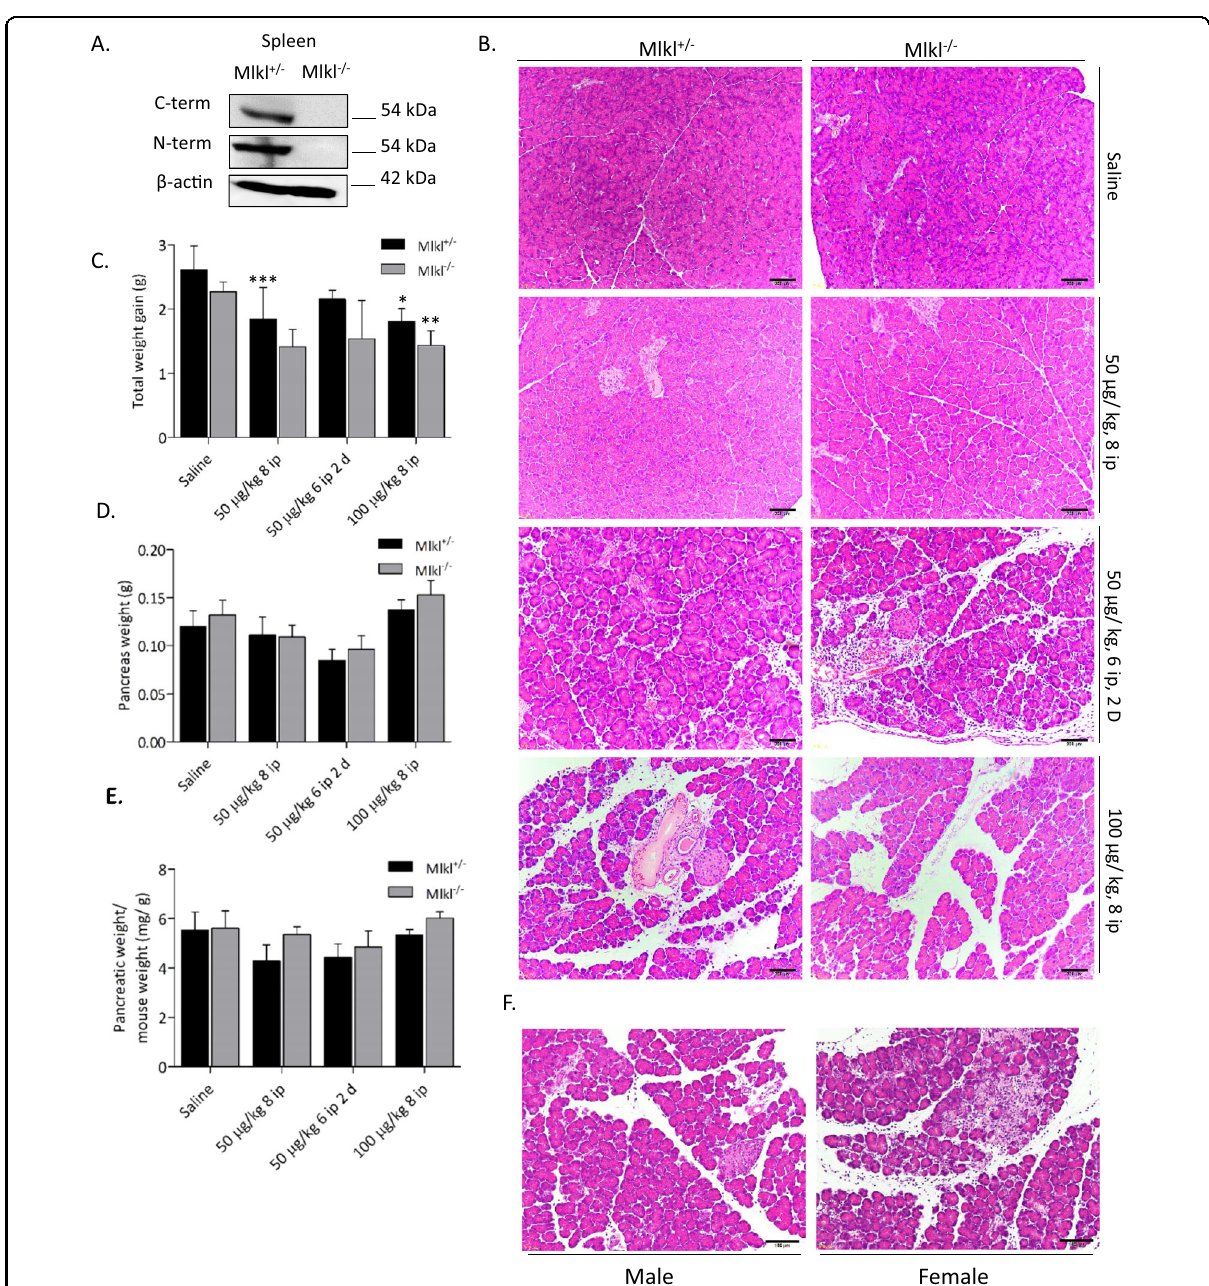
Fig. 1 Optimization of the protocol to induce acute pancreatitis in vivo. A Western blot of MLKL expression in splenocytes from Mlkl + / − and Mlkl − / − mice by using antibodies recognizing the C- and N-terminal domains of MLKL. Mlkl + / − and Mlkl − / − mice received intraperitoneal injection of three doses of caerulein, 50 µg/kg/body weight at 8 h intervals, 50 µg/kg/body weight at 6 h intervals for 2 days, and 100 µg/kg/body weight at 8 h intervals. Twenty-four hours after the fi rst injection, mice were sacri fi ced ( n = 5 − 10 in each group). B Representative haematoxylin and eosin (H&E) images of pancreases from Mlkl + / − and Mlkl − / − mice treated with or without caerulein. C Total weight gain (grams), D pancreas weight gain (gram), and E the ratio of pancreatic weight to the fi nal body weight (milligrams to gram) were determined. F Representative H&E images of pancreases from male and female Mlkl − / − mice after receiving caerulein for 8 h. Data are present as means ± SE. * P < 0.05, ** P < 0.01, and *** P <